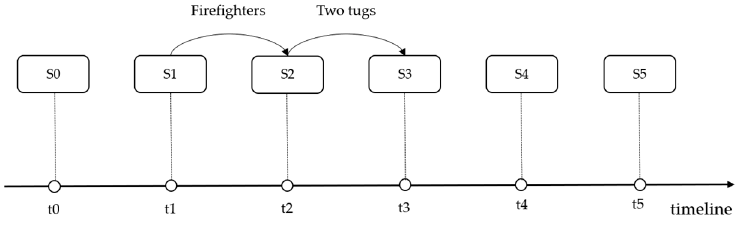
Figure 7. The scenario instances of the ATLANTIC EMPRESS.